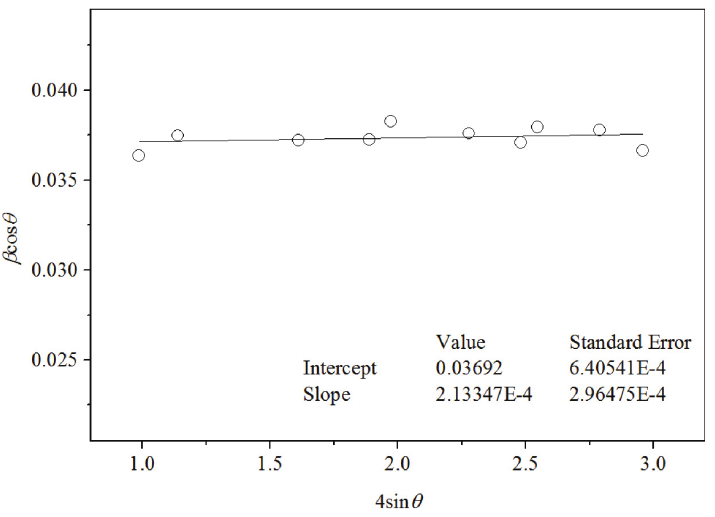
Fig. 2 – Williamson-Hall plot of the prepared catalyst